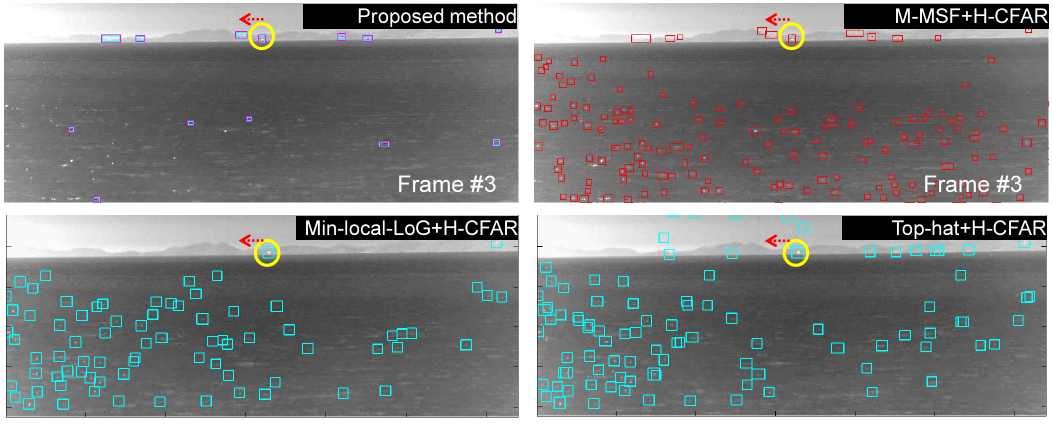
Figure 28. Target detection comparison between the proposed method and the baseline method for test Set